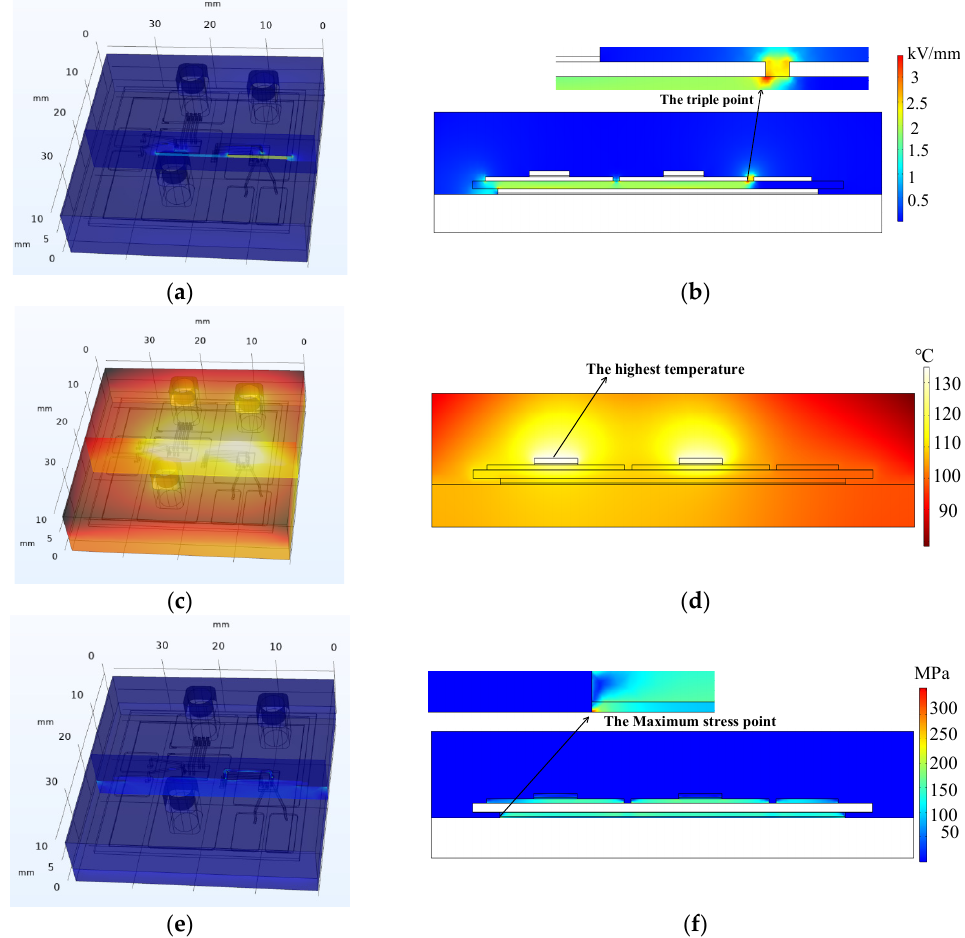
Figure 7. The distribution of the electric field, temperature, and mechanical stresses of power module packaging: ( a ) 3D view of electric field distribution, ( b ) cross-section view of electric field distribution, ( c ) 3D view of temperature distribution, ( d ) cross-section view of temperature distribution, ( e ) 3D view of mechanical stress distribution, ( f ) cross-section view of mechanical stress distribution.